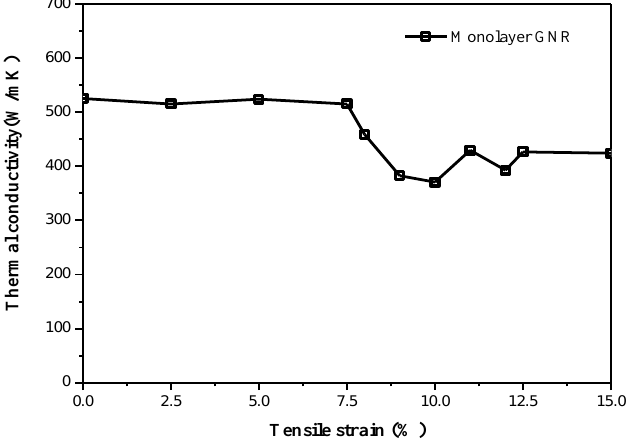
Figure 2. Tensile strain-dependent thermal conductivity of monolayer